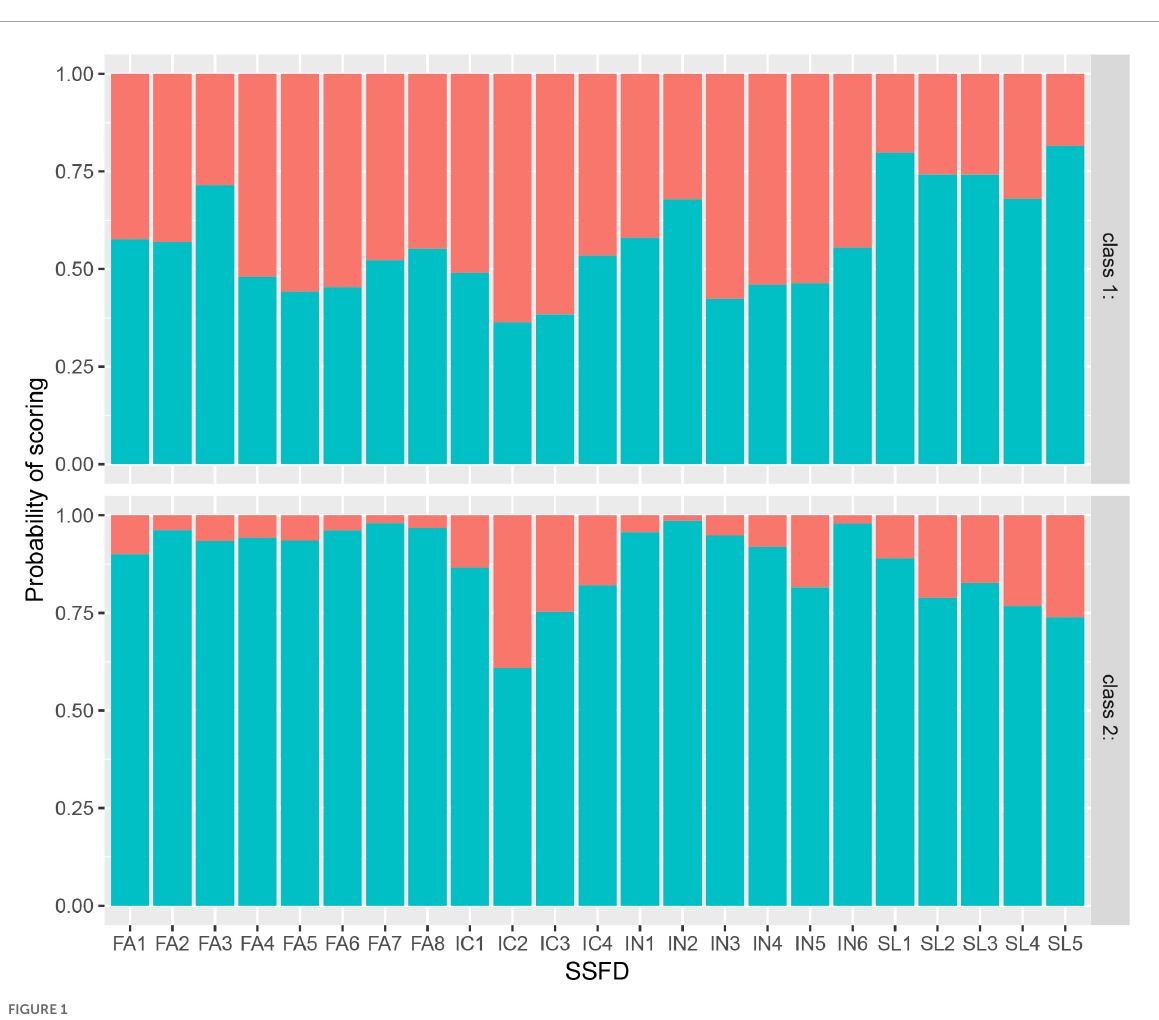
p < 0.001), IN (OR = 0.964, 95% CI: 0.960–0.968, p < 0.001), SL (OR = 0.986, 95% CI: 0.982–0.990, p < 0.001), and IC (OR = 0.990, 95% CI: 0.986–0.992, p < 0.001) were significantly associated with depressive symptoms after adjusting for age, gender, number of children in the family, parental preference, parental relationship, and monthly family